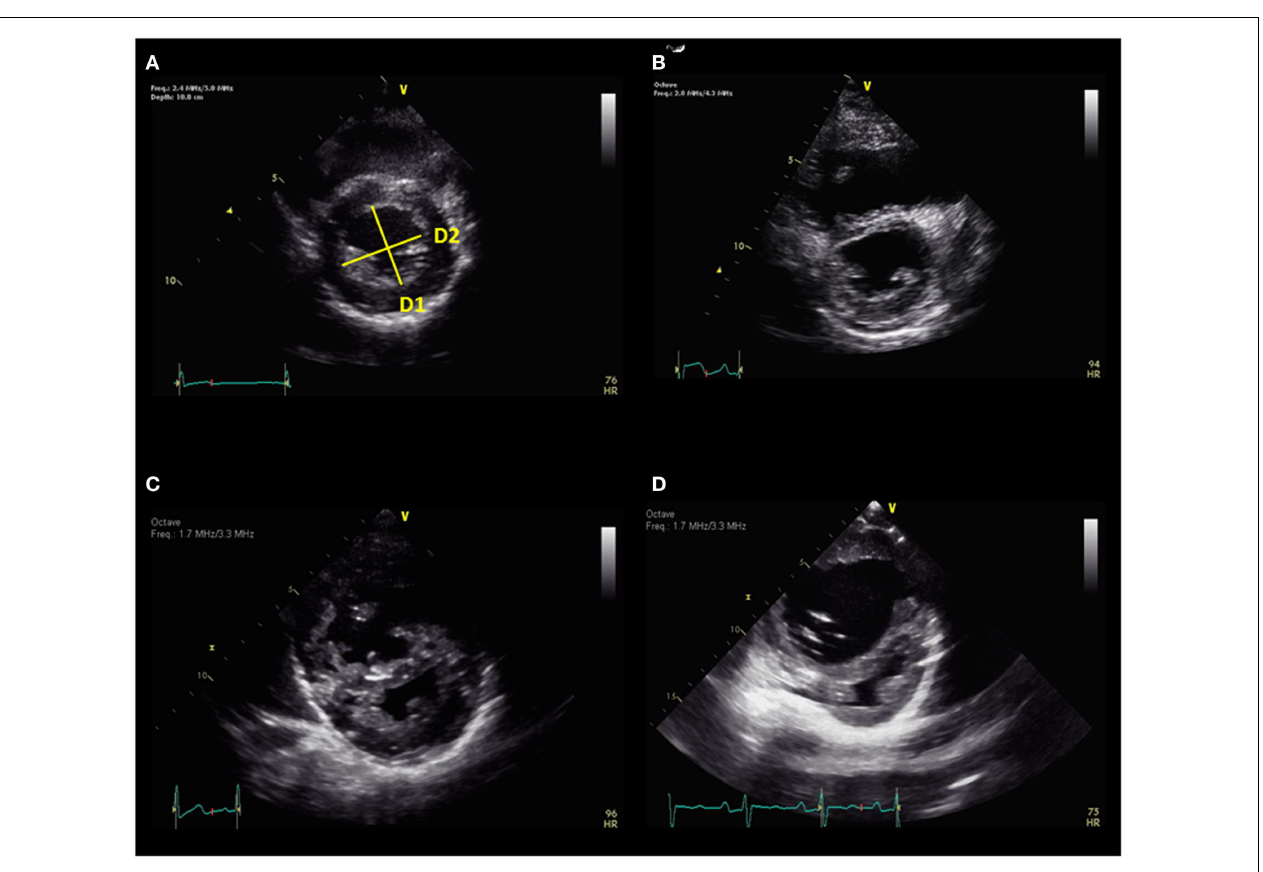
FIGURE 3 | (A) Eccentricity index = D2/D1 and normal septum.There is progressive septal flattening from mild (B) , moderate (C) , to severe (D) . D1 = diameter 1, D2 = diameter 2.